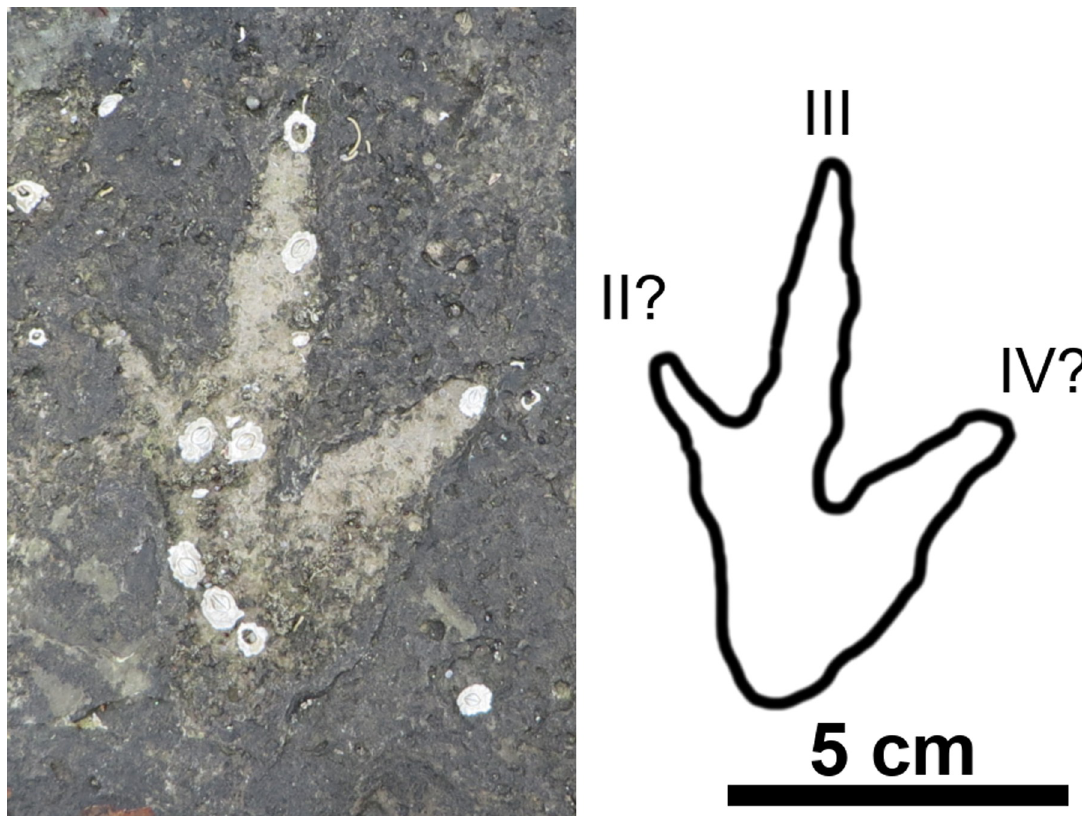
Fig 21. Small tridactyl track from BP3 (BP3_13). BP3_13 is shown with both a field photo and a line drawing. It is the smallest track at BP3. This narrow-toed track morphology–typical of Triassic and Early Jurassic tracks–is unique with regard to all other tracks at BP1 and BP3.